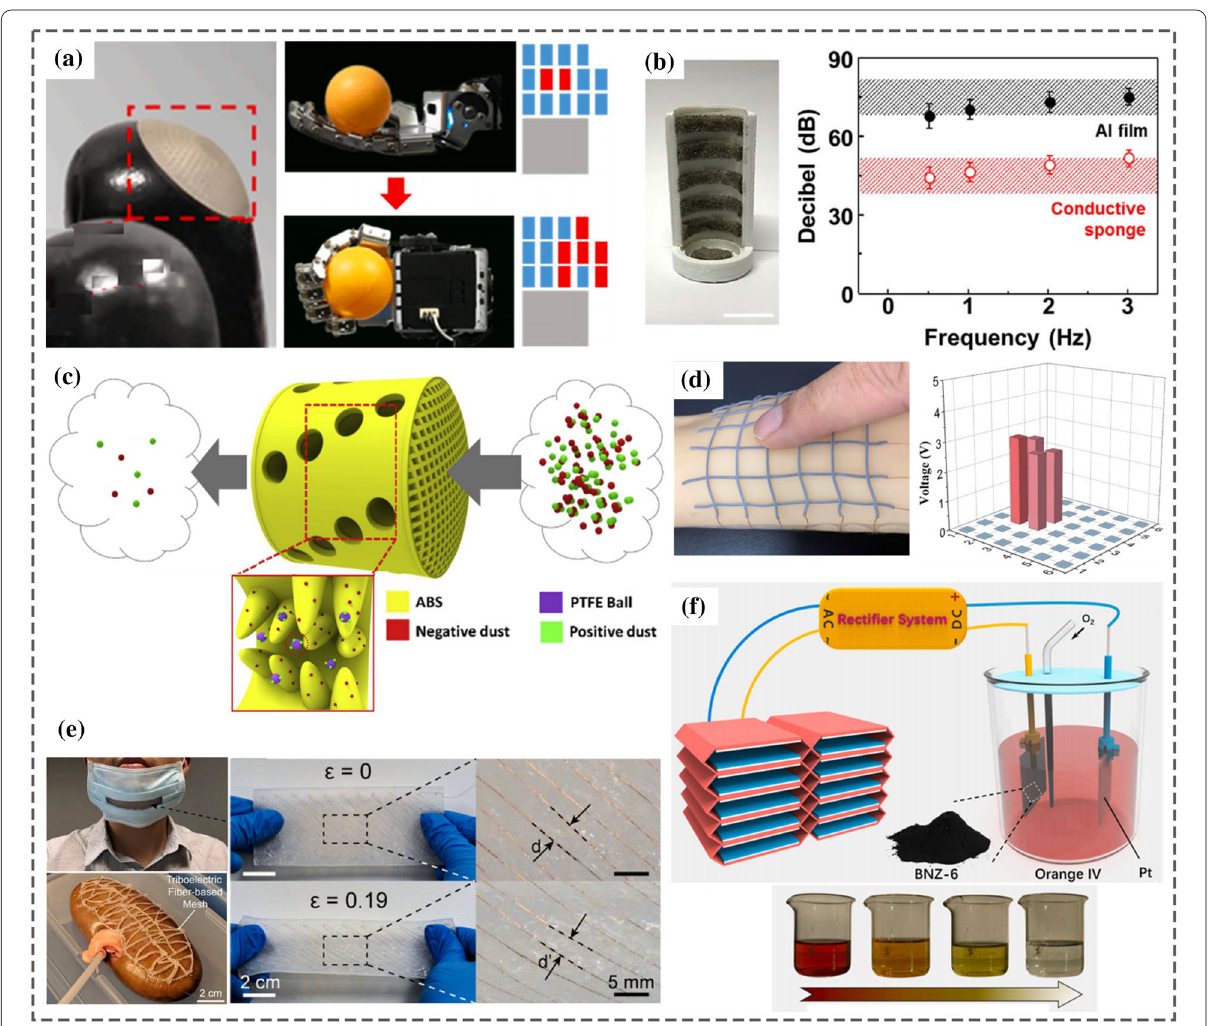
Fig. 15 Emerging applications of 3D-printed nano-MEH systems a conformal strain sensors attached on robotic hand showing the holding and gripping of a ball [175] b 3D printed noise-cancelling TENG causing a reduction of approximately 20 dB in the noise level of a normal conversation [150] c a 3D-printed biomimetic villus structure acting as an eco-friendly dust-adsorption system [148] d a 3D printed self-powered e-skin with meshed structure and corresponding 3D output voltage signal [176] e a human wearing an orthogonally stretchable triboelectric facemask and 3D-printed TENG fiber-based mesh of a kidney-conforming sensor [177] f a self-powered pollution degrading electro-Fenton (EF) system used for discoloration processes of the organic pollutant (Orange IV) solutions [178], (Images are re-used with the permission of the